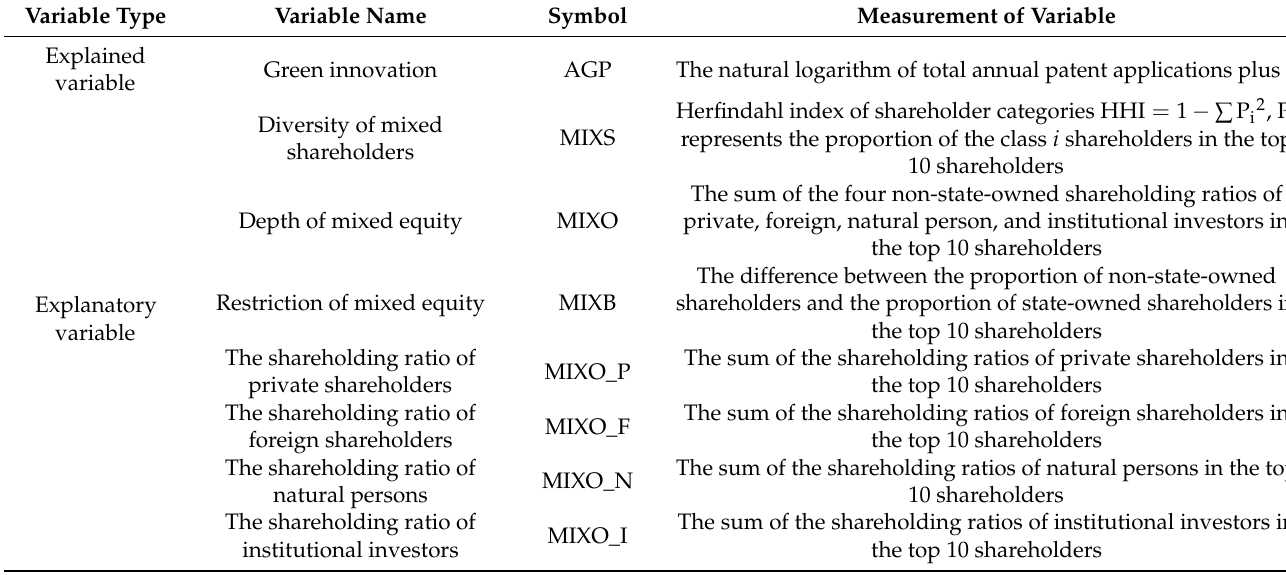
Table 1. The definitions and descriptions of the